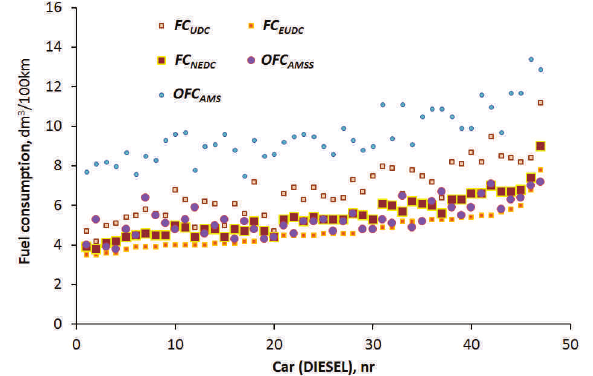
Fig. 6. The research results of fuel consumption in bench tests (FC NEDC , FC